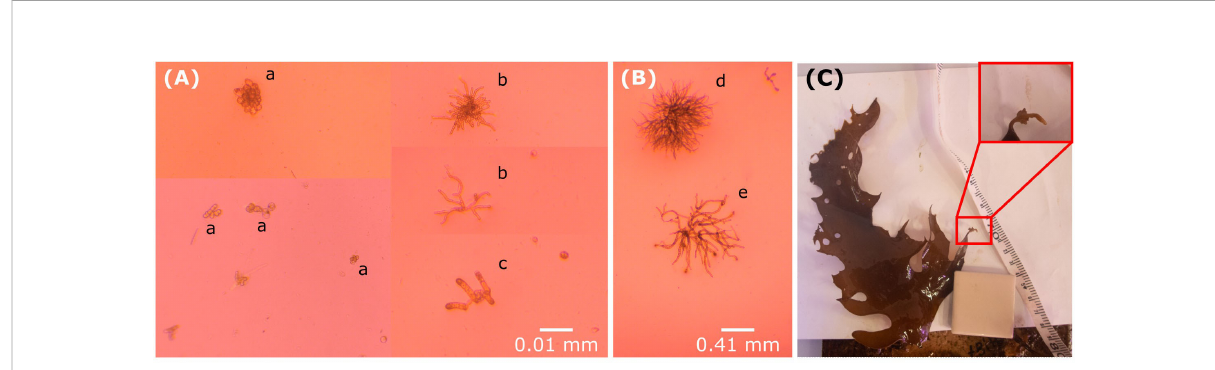
FIGURE 7 Examples of Ecklonia radiata in Hamelin Bay, Western Australia. (A) Gametophytes developed from spores from a clonal sporophyte and (B) a ‘ normal ’ haplodiplontic sporophyte. a) gametophyte cell clumps without branching, b) male gametophyte, c) female gametophyte, d) male gametophyte, e) female gametophyte. (C) Lab grown clonal lateral (cut from parent clonal plants) growing into a new adult individual with the formation of its own new haptera at the top of its own secondary lateral. Pictures taken one month after start of